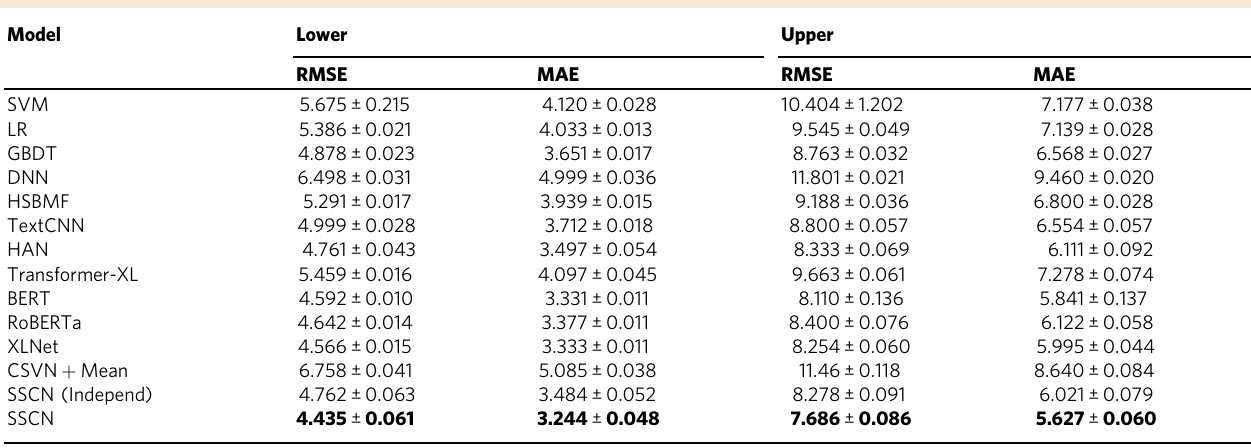
Table 2 Performance evaluation on salary